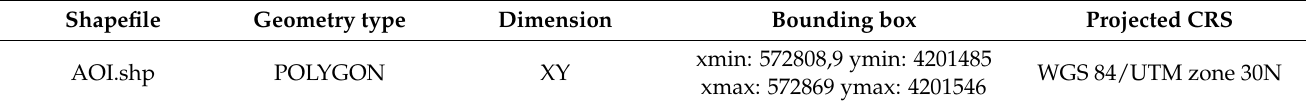
Table 4. Area of Interest (AOI)